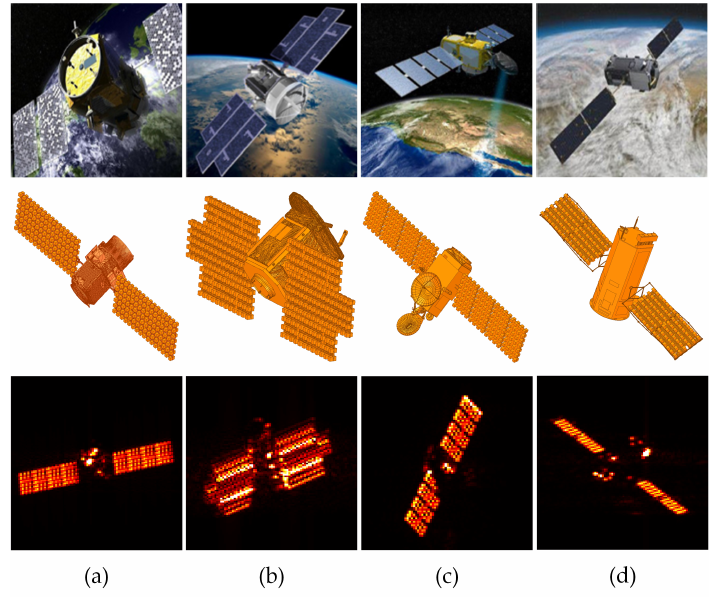
Figure 8. The optical images, CAD models, and ISAR images of ( a ) CALIPSO, ( b ) Cloudsat, ( c ) Jason-3, and ( d ) OCO-2.